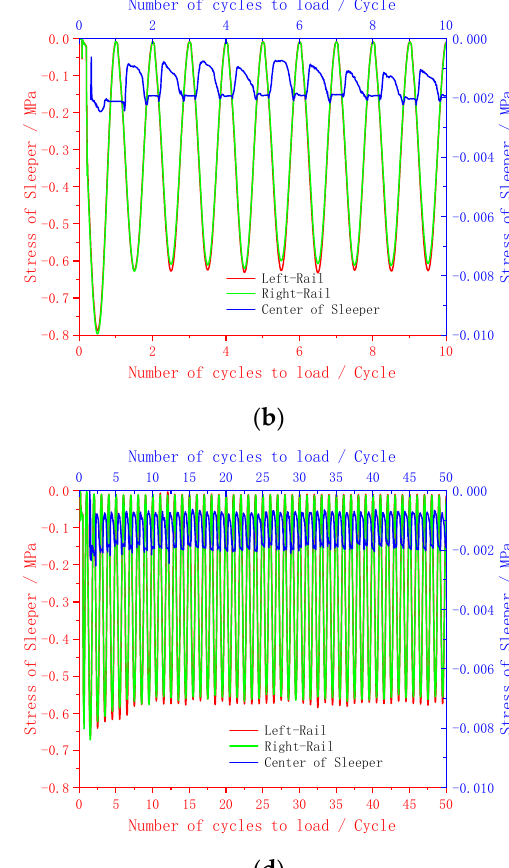
the load, and the sleeper model was not very stable. After continuing to cyclically load the sleeper, the stress change trend in the sleeper tended to be stable. The stress of the sleeper area under the rail enlarged significantly, while the stress peak at the center of the sleeper was smaller. Under different loading frequencies, the peak values of the sleeper stress under the left and right strand rails were close to each other, approximately 0.6 MPa, and the maximum compressive stress at the center of the sleeper was not much different, with both being approximately 0.002 MPa. The variation law of the stress in the sleeper is similar to the variation of the applied load, and both show a sinusoidal distribution. Due to the symmetry of the geometric distribution of sleepers and rails and the symmetry of the load action, the stress change and stress peak value of the sleeper under the left and right strand rails are the same, and the stress change curves of the two almost coincide.